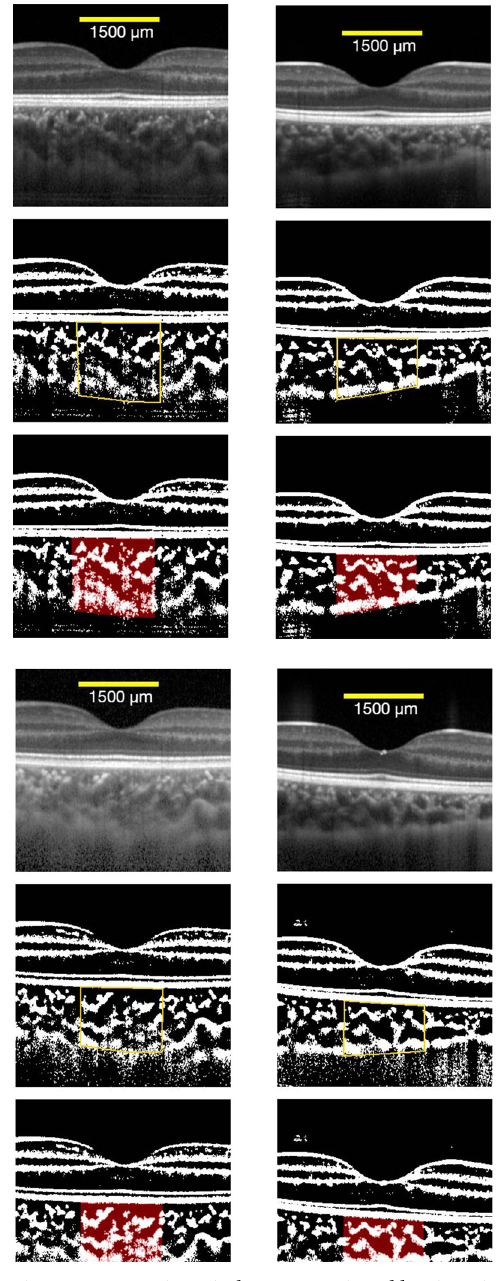
Fig 3. Representative anisohypermetropic amblyopic patient and control subject. The choroidal area was 1500 μ m 2 at 750 μ m nasal and 750 μ m temporal to the fovea. Vertically, the area measured extended from the retinal pigment epithelium to the chorioscleral border (yellow line). The measured area of the choroid is demarcated (Top). The image is converted to a binary image by the Niblack method by the of ImageJ software (Middle). The dark area which is the luminal area is represented by the red area (Bottom). A: amblyopic eye before the treatment B: control eye at the baseline C: amblyopic eye after the treatment 3D: control eye after one year.